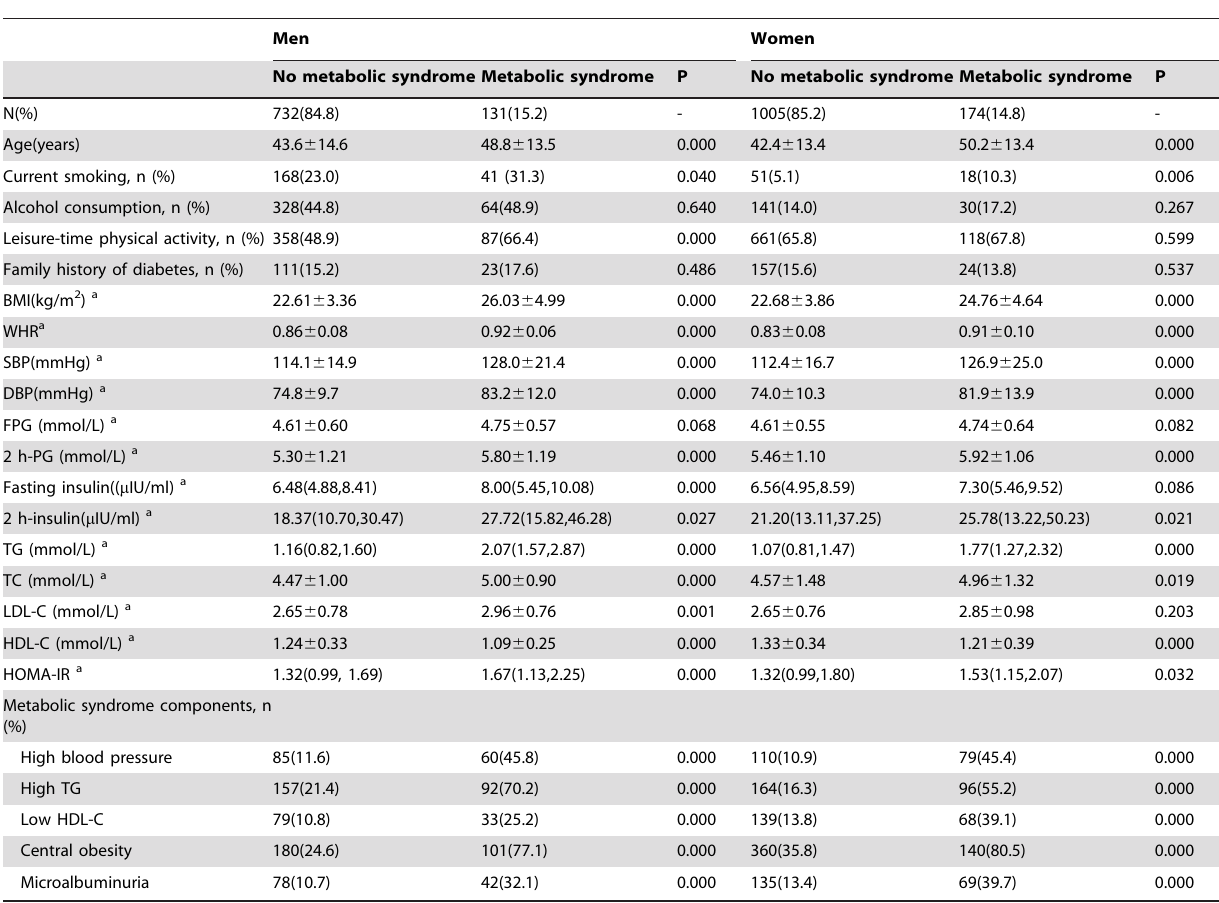
Table 1. Baseline characteristics of study population by incident metabolic